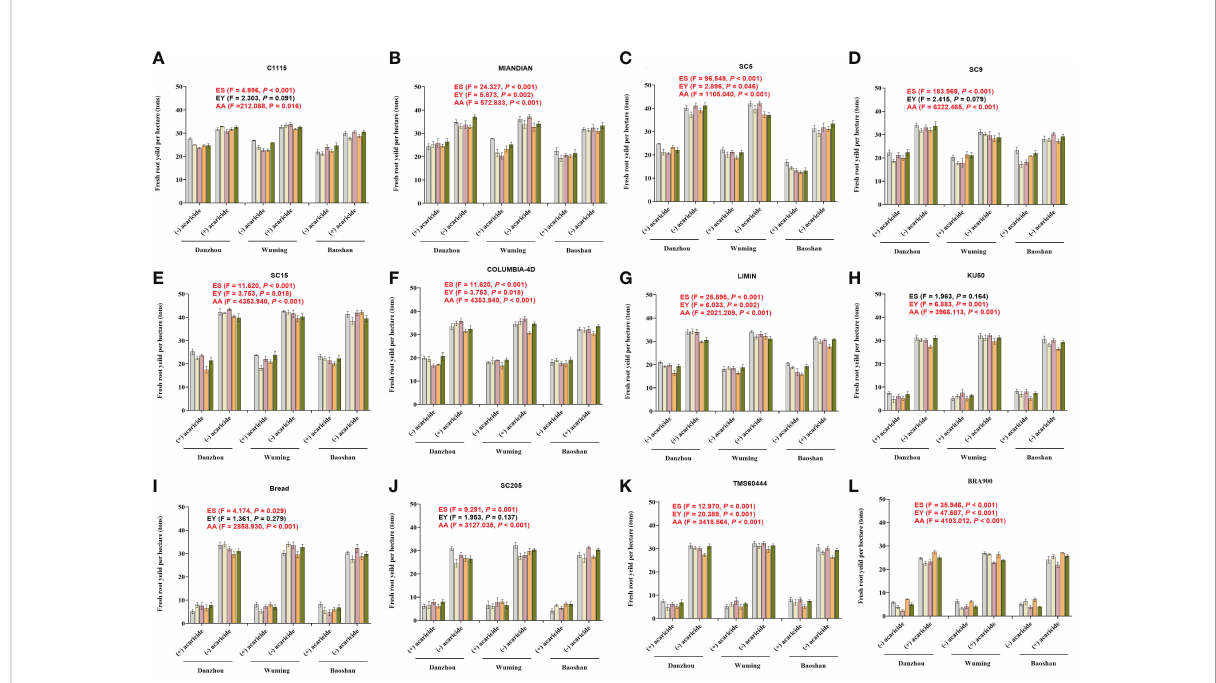
FIGURE 5 The capacity of 12 cassava varieties in reducing the yield losses during the fi eld validation. (A) C1115. (B) MIANDIAN (C) SC5. (D) SC9. (E) SC15. (F) COLUMBIA-4D. (G) LIMIN. (H) BRA900. (I) SC205. (J) BREAD. (K) TMS60444. (L) BRA900. “ + ” indicates acaricide application, while “ - ” indicates without acaricide application. Generalized linear mixed model was used to analyze the multiple effects such as acaricide application, experiment sites, and years of experiments on the cassava yield. The F - and P -values are indicated within panels (A – L) . Moreover, the P -values that represent statistical difference are marked in red (signi fi cance level = 0.05).